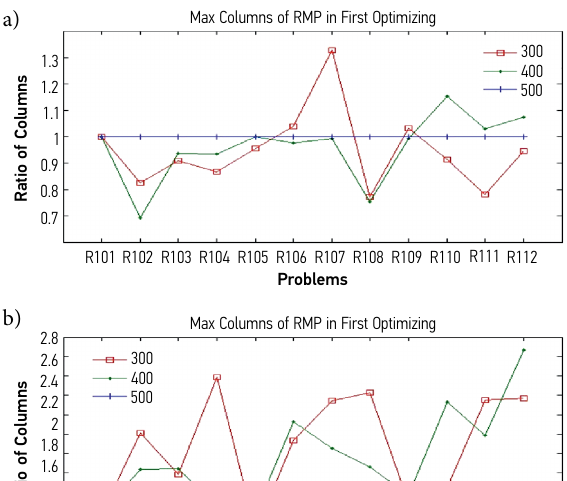
Fig. 4. Comparison of main-problem scale under different condition and searching number: a – main-problem scale under CS; b – main-problem scale under